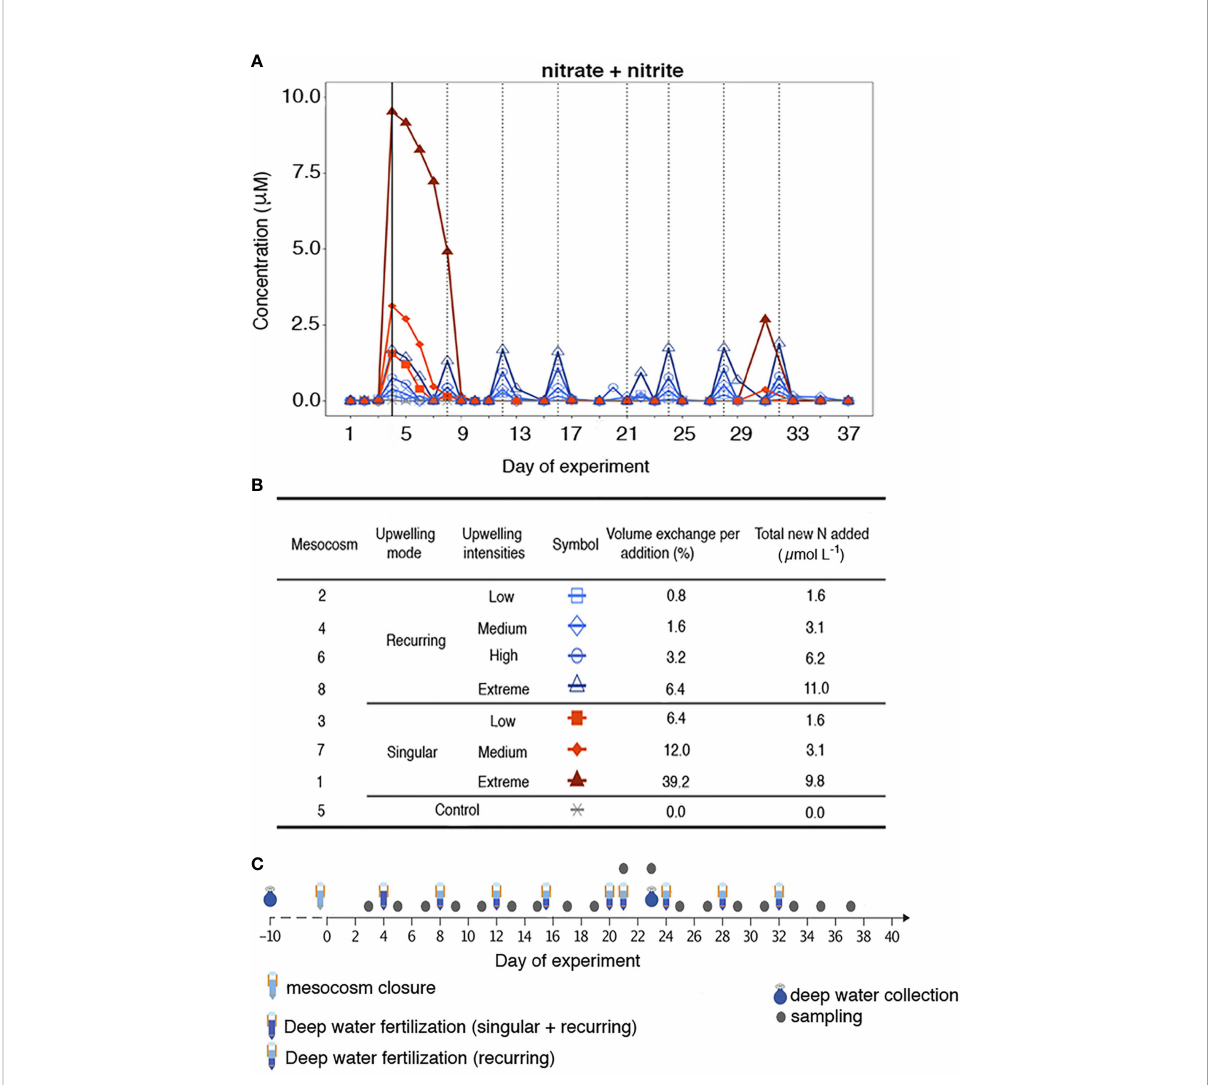
FIGURE 1 (A) Nitrate + nitrite evolution during the experiment. The solid black line indicates the fi rst deep-water addition (except in the control). The dotted black lines indicate the addition made only to the recurring treatment. (B) Types of treatment, symbol encoded, mesocosms, volume exchange per addition (%) and total new N added ( m mol L-1). (C) Mesocosms sampling timeline adapted from Baumann et al.